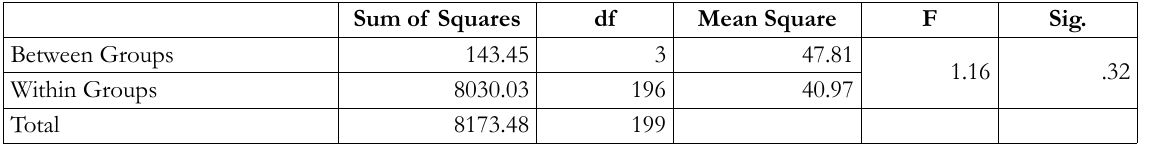
Table 1. ANOVA test